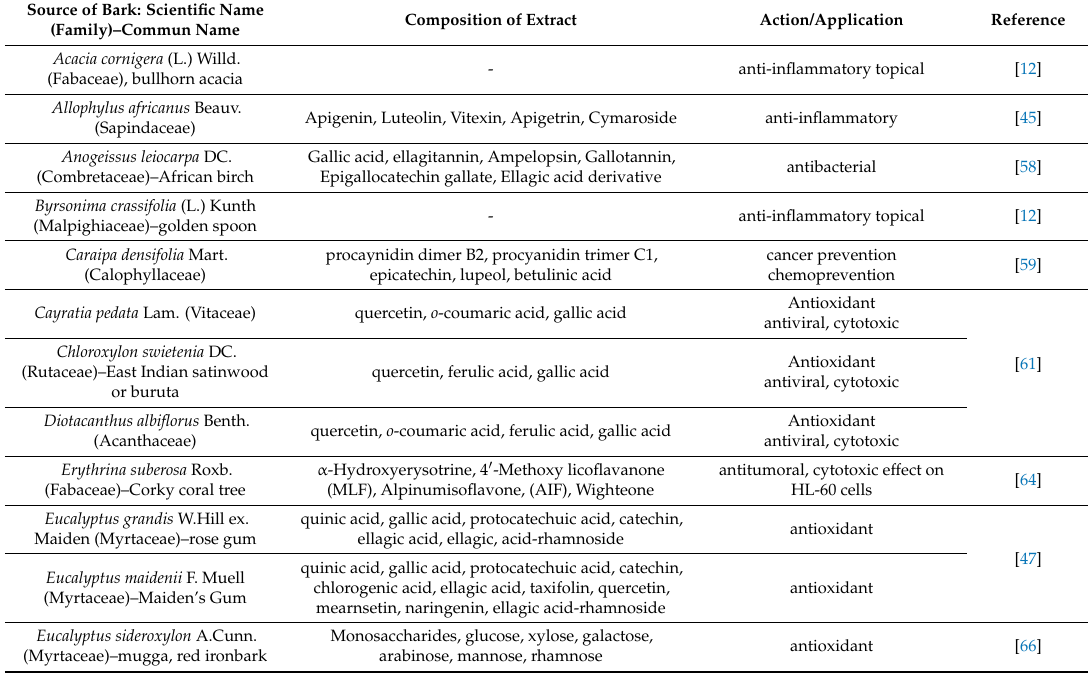
Table 2. The biological action of the extracts obtained from the bark of woody vascular plants. Source of Bark: Scientific Name (Family)–Commun